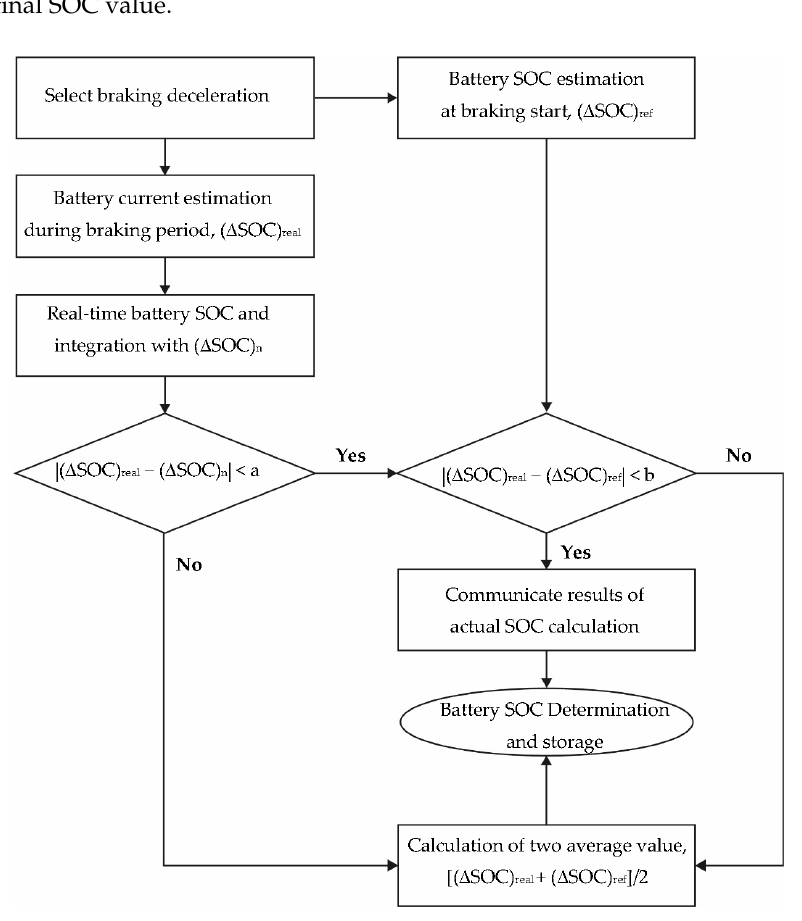
Figure 7. Algorithm flowchart for SOC determination.